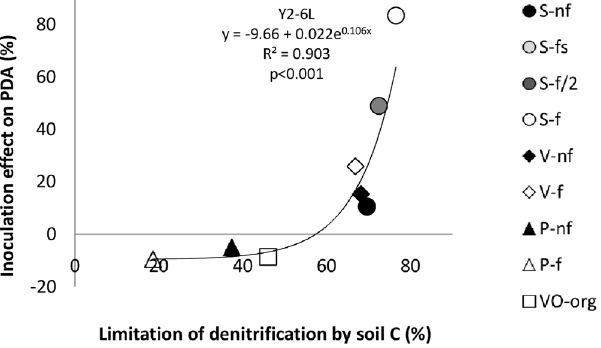
Figure 2. Relationship between the effect of inoculation on PDA and the level of limitation of denitrification by endogenous soil C org . Relationship between the effect of inoculation on potential denitrification activity, PDA, and the level of limitation of denitrification by endogenous soil C org at the 6-leaves stage, year 2 (Y2-6L). C limitation was assessed from values of semi potential denitrification measured without C addition and PDA values. Symbols for sites and fertilization treatments are as in Fig. 1. Each point corresponds to the mean value observed for n = 5 plot pairs (i.e. with and without inoculation).